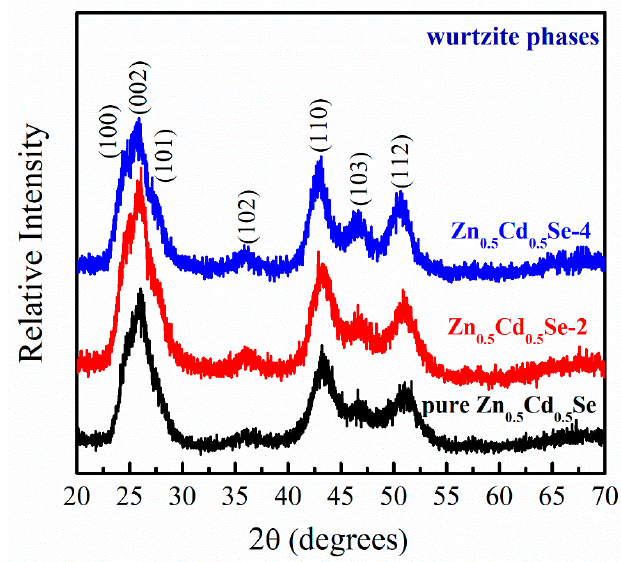
Figure 1. X-ray diffraction (XRD) patterns of Zn 0.5 Cd 0.5 Se alloy quantum dots (QDs) with low oleylamine (OLA) content.